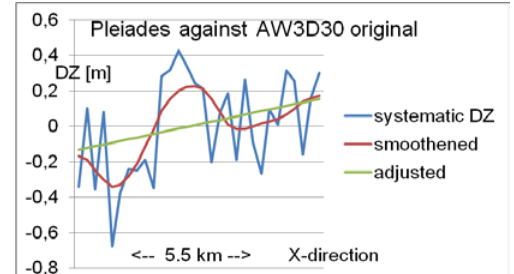
Fig. 15. Systematic height errors in X-direction, Zonguldak, original Pléiades DSM against AW3D30